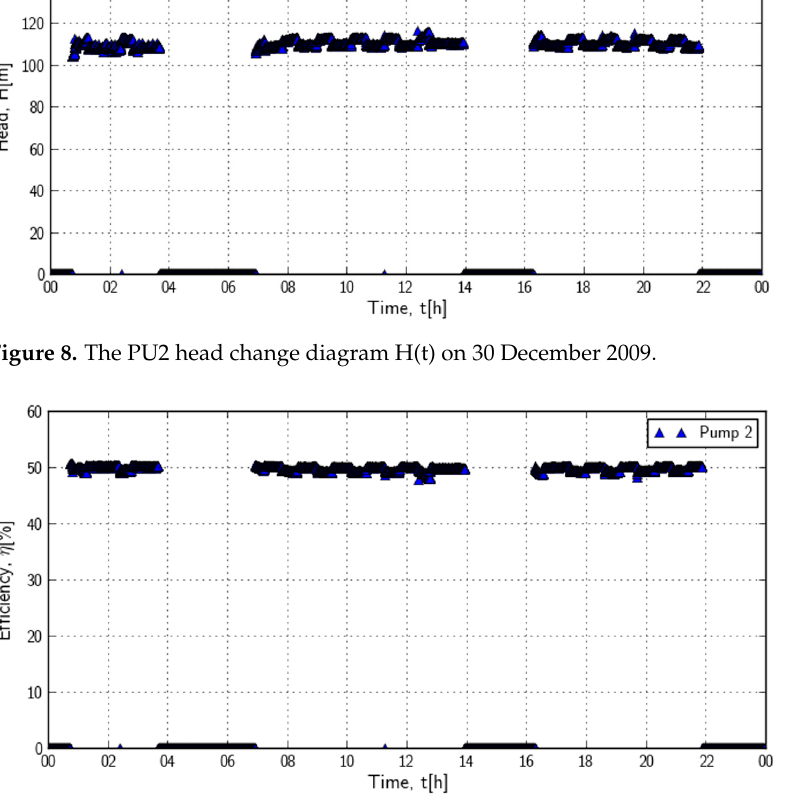
Figure 9. The PU2 efficiency change diagram η (t) on 30 December 2009.